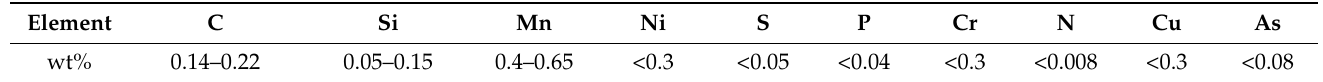
Table 1. Chemical composition of carbon steel grade St3sp.